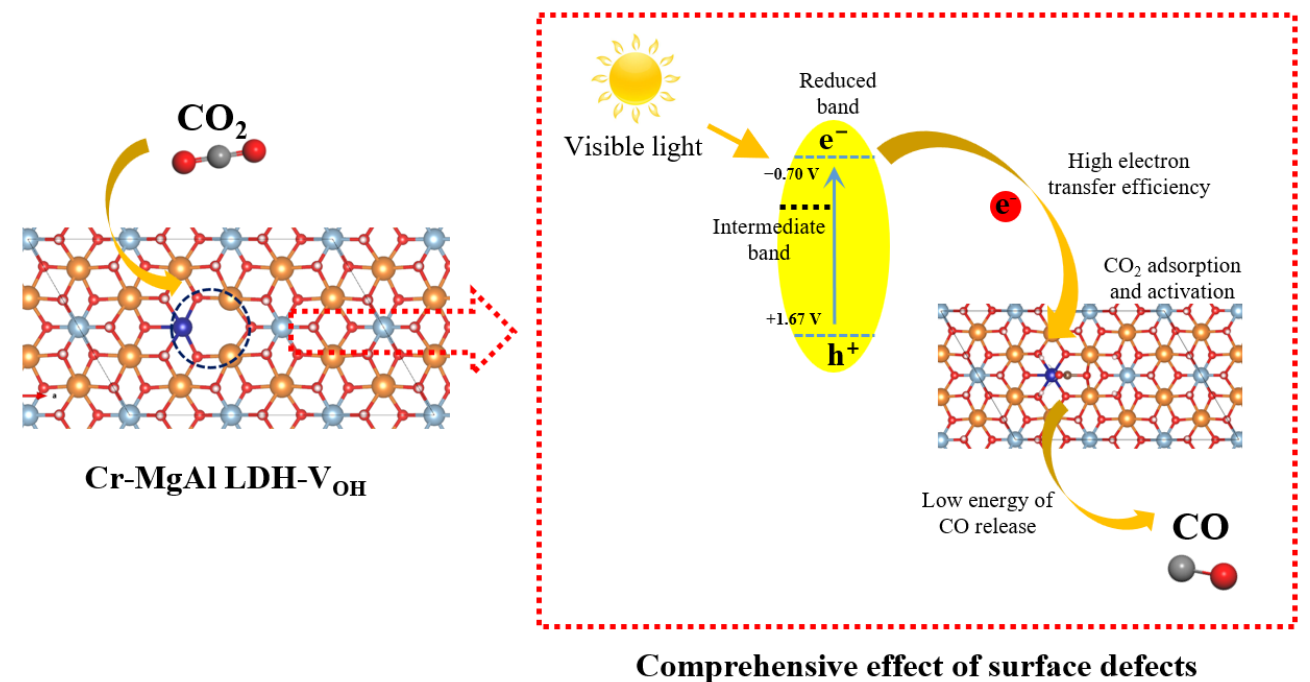
Figure 7. Mechanism diagram of Cr doping into MgAl-LDH in CO 2 photoreduction [48].